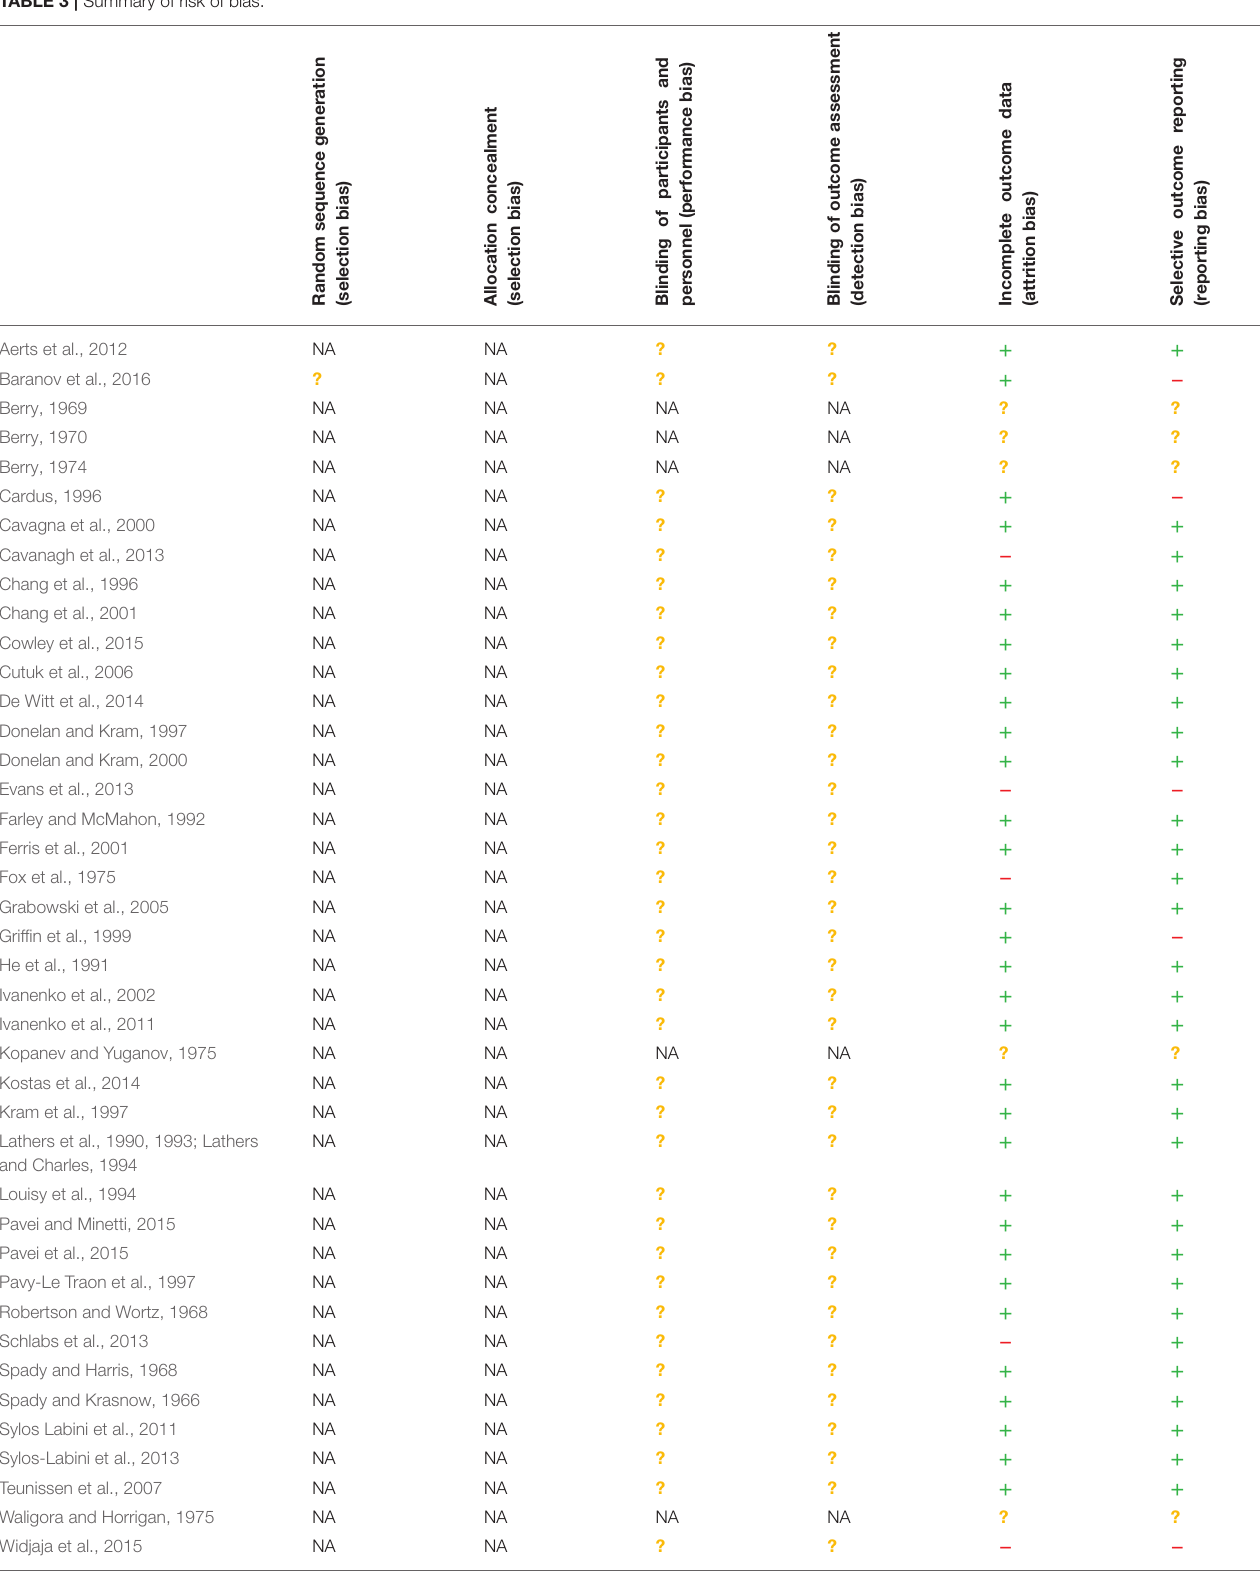
TABLE 3 | Summary of risk of